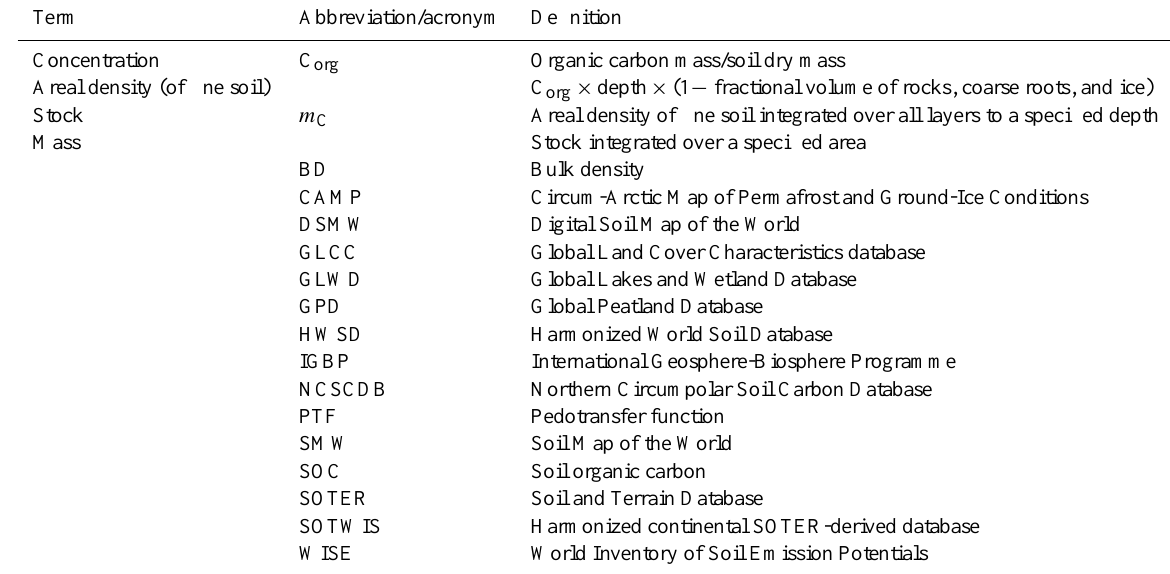
Table 1. Definition of terms with respect to organic soil